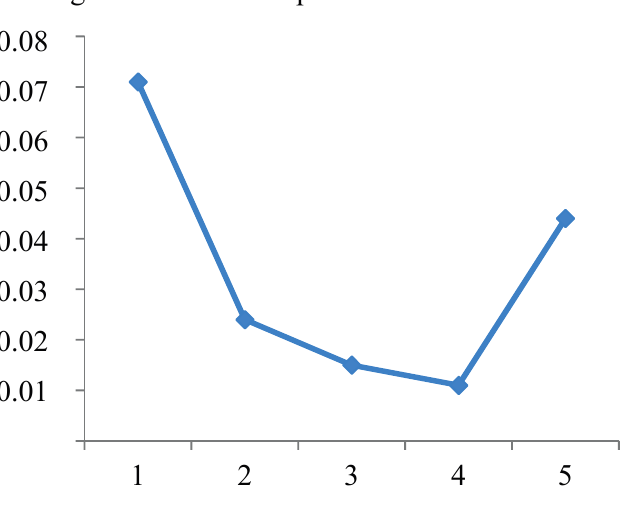
Figure 4. Plot of the average of maximum amplitudes FFT power spectral of AE signal vs. polishing session.